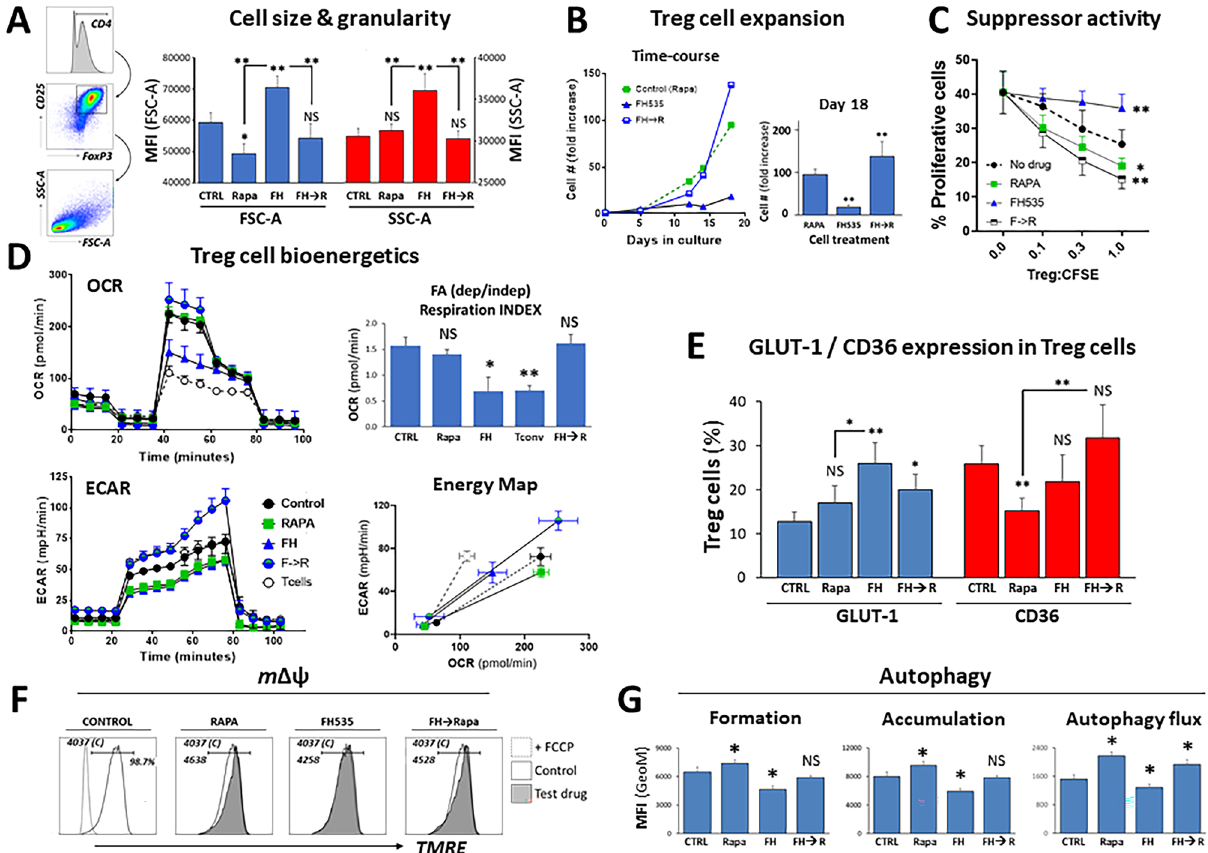
Figure 4. Rescue of FH535-induced functional decay of Treg cells after sequential addition of Rapamycin (FH535 → Rapa) linked to metabolic cell restitution. Tconv or Treg cells were cultured without (Control) or with Rapa alone, FH535 alone, or FH535 alone for two days followed by the combination of Rapa and FH535 (FH → Rapa). ( A ) Left vertical panels illustrate gating strategy used for scatter dot plot ( FSC forward scatter; SSC side scatter) analysis of Treg cells. Right column graph depicts pooled data of the relative size (FSC) and granularity (SSC) in Treg cells after 4-day culture in different drug regimens. Results are indicated as mean GeoMFI values ± SD from four independent experiments. ( B ) Representative long-term time-course Treg cell expansion showing the relative fold increase of cell numbers with respect to the original (day 0). Column graph of pooled data from four independent experiments showing fold-increase in cell numbers (mean ± SD) after 18-days in culture. ( C ) Suppressor activity of Treg cells exposed to drug treatments for seven days from three independent 4-day MLR assays. ( D ). Treg cell bioenergetics after 7-days culture with the different drug treatments. Untreated Tconv profile was included as an additional comparative condition. Top panels show the OCR profiles with the corresponding (FA-dependent/FA-independent) respiration indexes. Bottom-left panel shows the ECAR profiles. Bottom-right panel shows Cell Energy Phenotype Profiles as scatter plots of OCR ( X -axis) and ECAR ( Y -axis) depicting the metabolic ranges (from basal to maximum stress levels) reached by the cells under the different treatments. Results show the mean ± SD from six replicates. ( E ) Pooled data from four independent experiments show the expression of GLUT-1 and CD36 in Treg cells after 7 days in culture with the corresponding drug treatment. ( F ) m ΔΨ in Treg cells after 4-days culture with the different drug treatments measured by TMRE (see “Methods” section). ( G ) Autophagic activity in Treg cells after 7-days exposure to the different treatments without (vesicle formation, left panel) or with CLQ (vesicle accumulation, central panel). Autophagic flux was determined by MFI differences of CytoID + cells between cells treated with CLQ and the corresponding cells without CLQ (right panel). Results are shown as mean ± SD of four replicates. Statistical differences were tested with ANOVA/Dunnett’s and Student’s t tests and are shown by *( p < 0.05) and **( p <